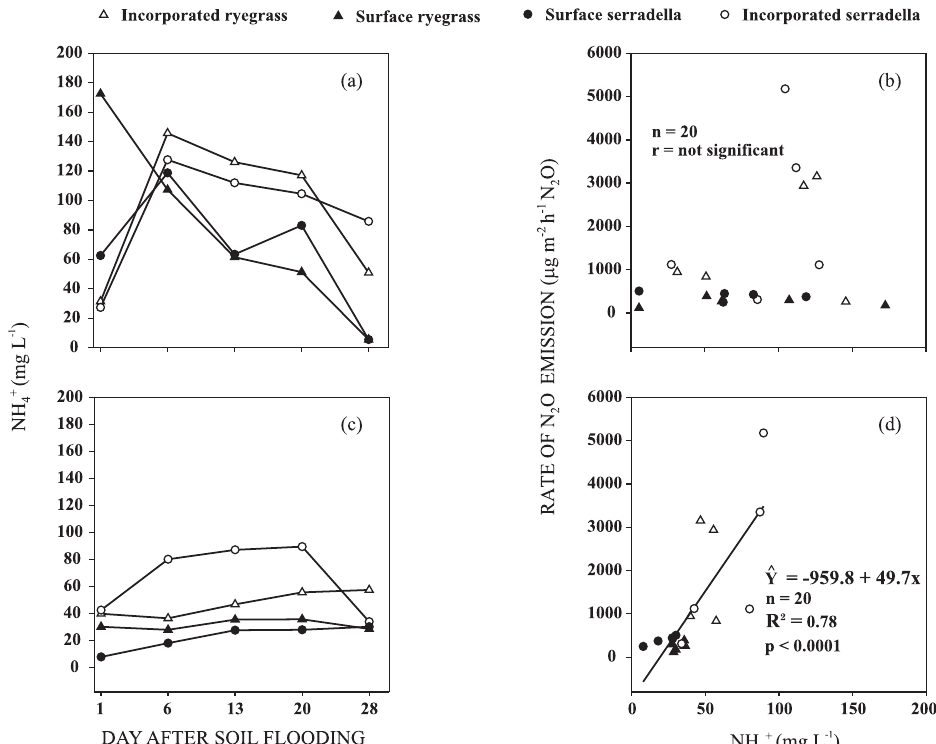
Figure 7. Concentration of ammonium (NH 4+ ) at depths of 2 and 20 cm (a and c, respectively) of a flooded Albaqualf as affected by residue managements (incorporated or left on the soil surface) of ryegrass and serradella, and the respective relationships with N O soil emissions (b and d, 2